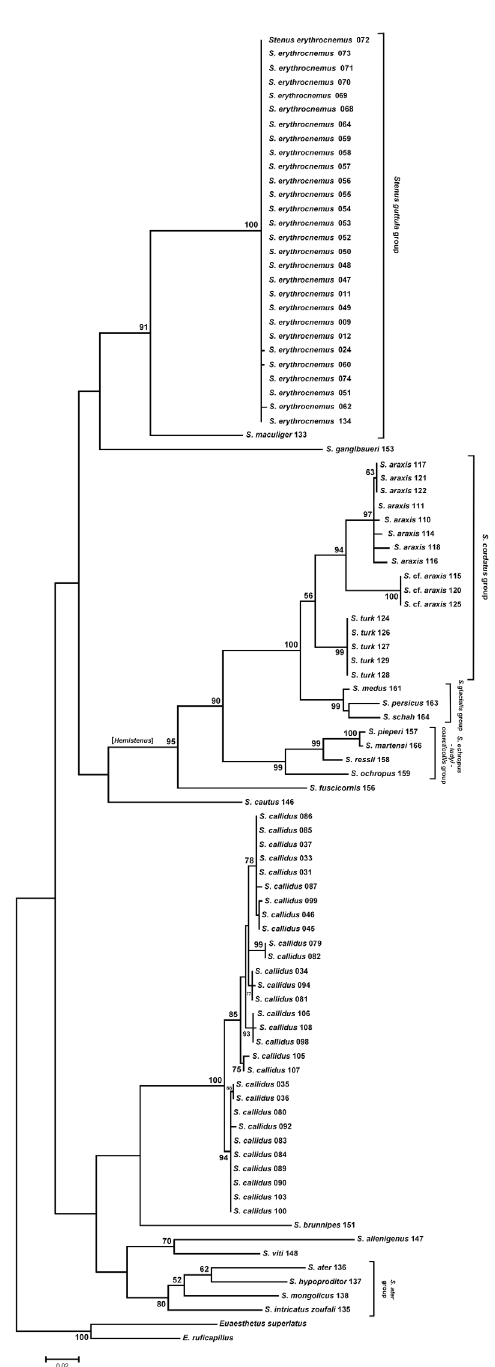
Figure 8. Maximum likelihood phylogram. Numbers on branches are bootstrap values (>50). The specimen codes correspond to the geographical information in Table 1. Scale shows number of substitutions per